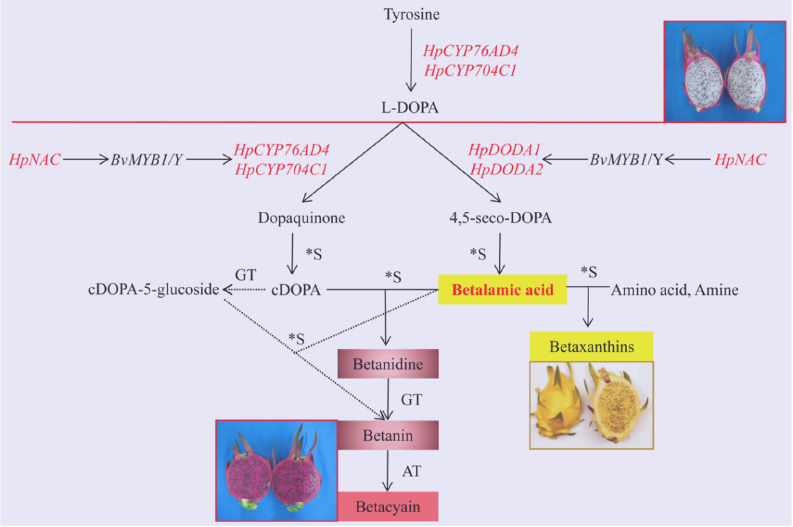
Figure 6. The putative betalain biosynthesis pathway from pitaya fruit. Note, the genes identified in red words were derived from our pitaya pulp data. The solid line arrows represent the common biosynthetic pathway of betalain, and the dotted line arrows designate reactions of an alternative pathway.